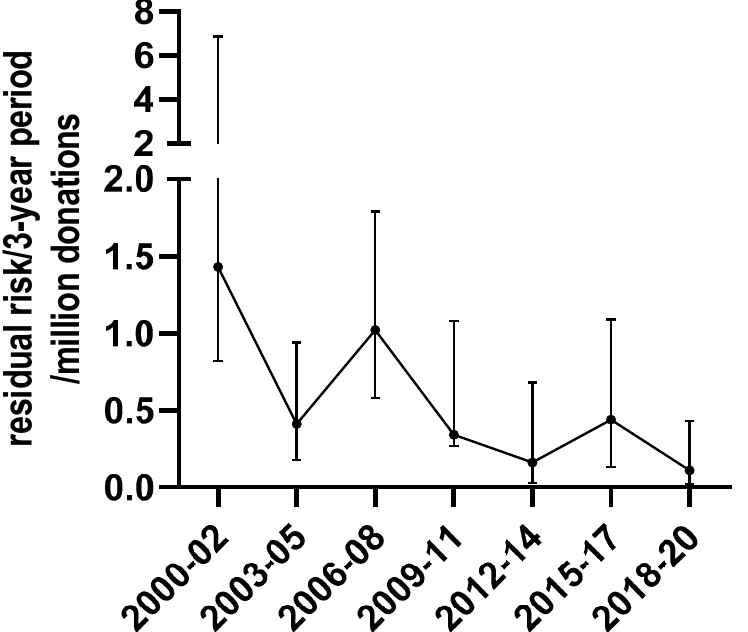
Figure 3. Evolution of the residual risk for HBV, based on the incidence/WP model in blood donations from 2000 to 2020.